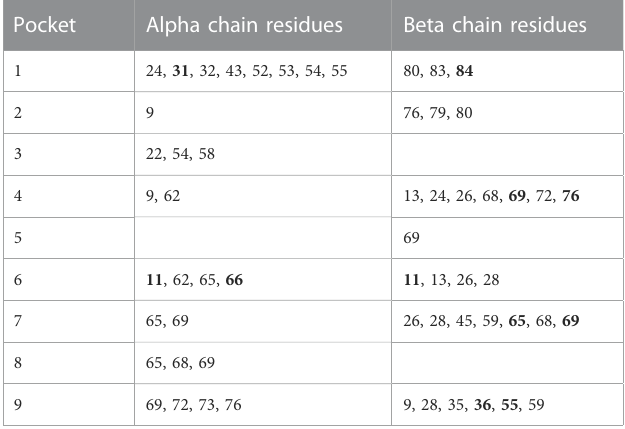
TABLE 4 Pocket Residues for DP proteins. Residues that are bold are identi fi ed to be polymorphic in Figure